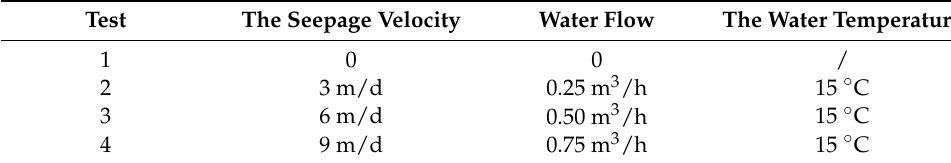
Table 2. Setting values of water flow parameters in the model test.